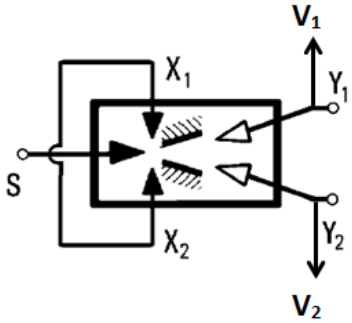
Figure 2. Vented Fluidic Oscillator (adapted from [37]) S is the supply nozzle where gas enters, X 1 and X 2 are the control terminals where gas switches , Y 1 and Y 2 are the outlets where microporous spargers can be connected with oscillatory gas output. These spargers are placed in liquid and generate bubbles, V 1 and V 2 (vents).